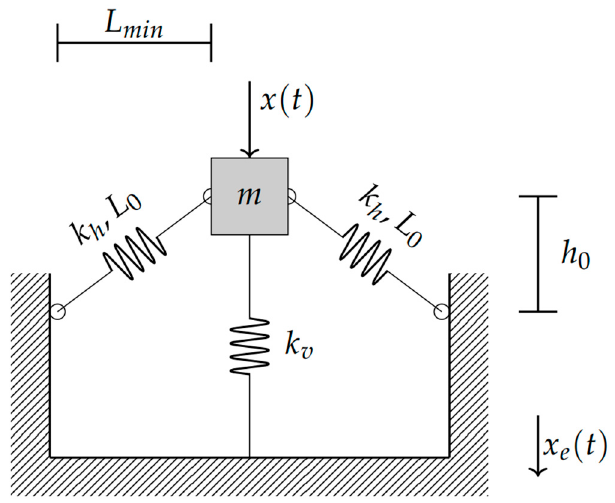
Figure 1. Quasi zero stiffness system using oblique springs.